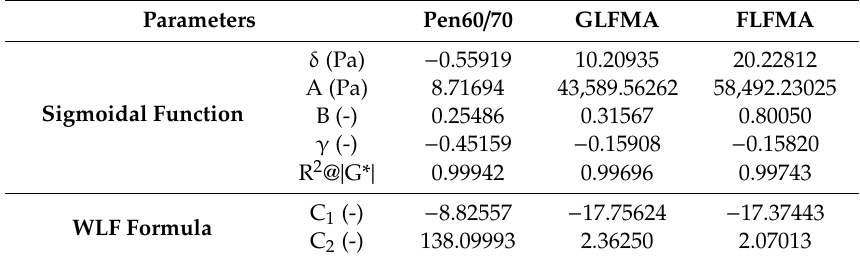
Table 5. Model parameters of sigmoidal function and the Williams–Landel–Ferry (WLF) formula. Parameters